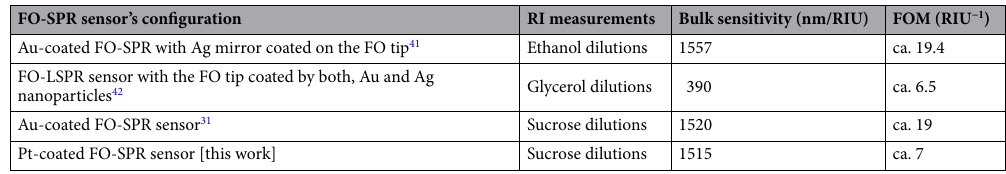
Table 2. Performance comparison data between different FO-SPR sensors.